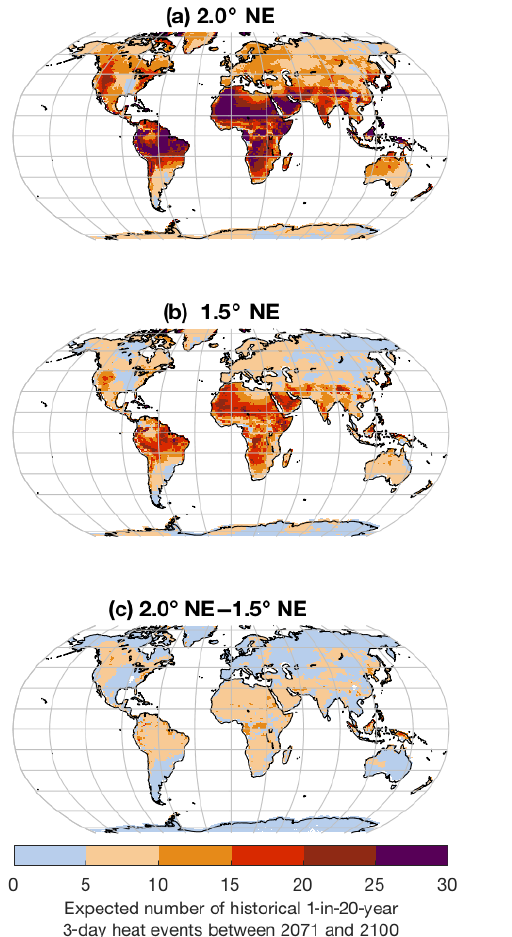
Figure 4. Maps showing the expected number of times that the modeled historical 1-in-20-year 3-day warm event in the period 1976–2005 would be exceeded during the period 2071–2100 for (a) 1.5degNE, (b) 2.0degNE and (c) the difference between the number of events in each scenario. By definition, no change from historical climate would correspond to a value of 1.5 events per 30